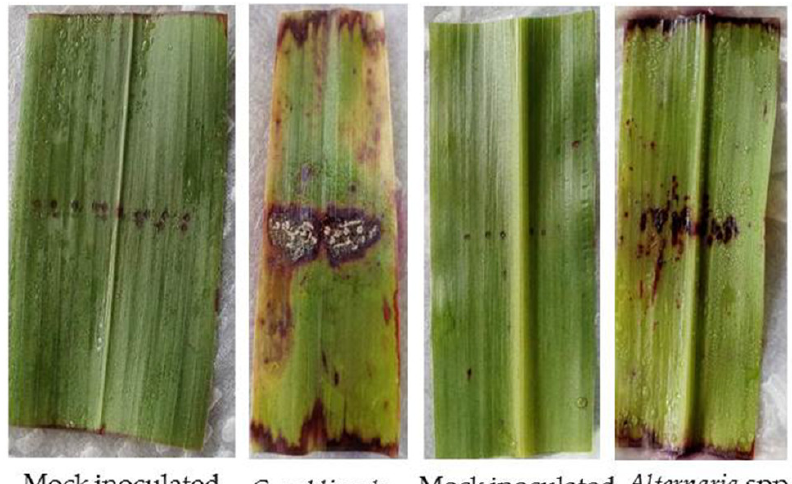
Figure 6. Sorghum leaf blades of cultivar Serena 10 days after inoculation with Colletotrichum sublineola and Alternaria spp.